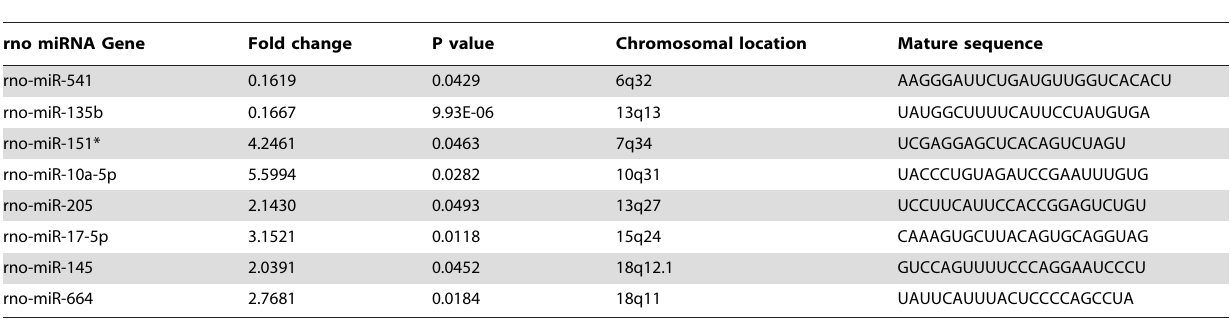
Table 2. Differentially expressed miRNA (fold change . 2, P ,